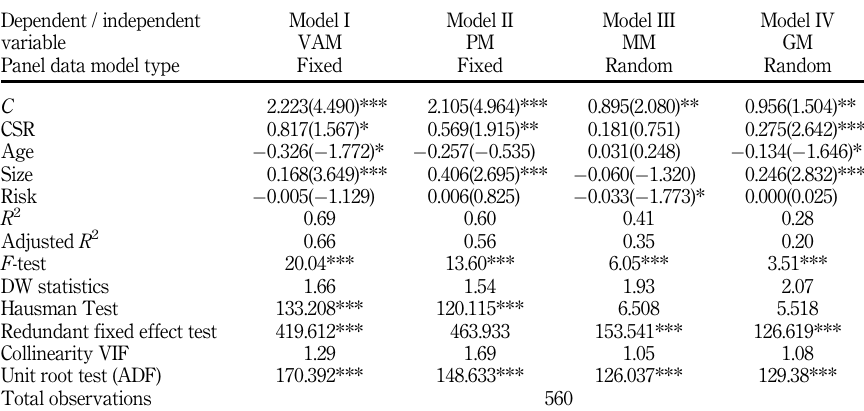
Table 8. Results of panel data regression